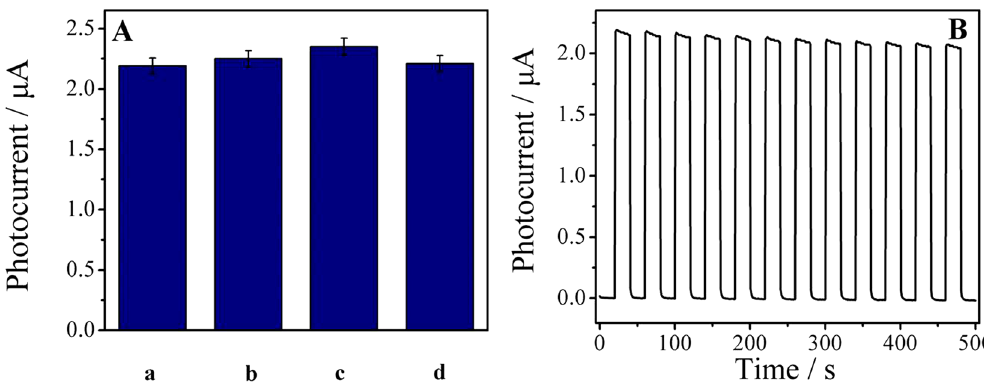
Figure 6. ( A ) The selectivity of the sensor (a) PSA, (b) PSA + CEA, (c)PSA + lgG, and (d) PSA + BSA. ( B ) The stability of the sensor.